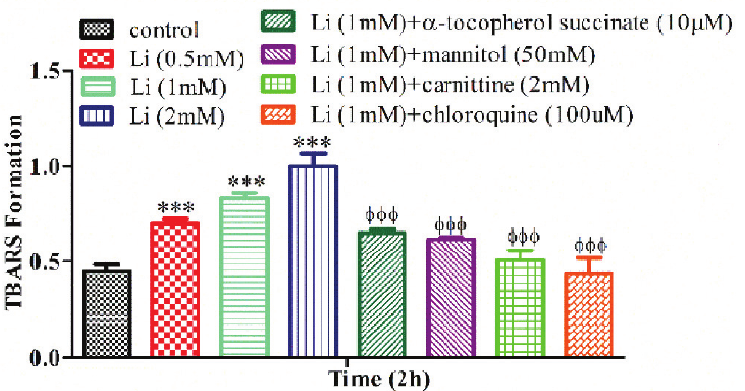
Figure 3: Effect of different concentrations of Li on lipid peroxidation using primary neuronal cortical culture. TBARS formation was measured spectrophotometrically and expressed as μM concentrations. Values are shown as mean ± SD of three separate experiments (n = 3). *** p < 0.001, significant difference in comparison with non-treated neurons (control). ɸɸɸ p < 0.001, significant difference in comparison with Li (1 mM)-treated